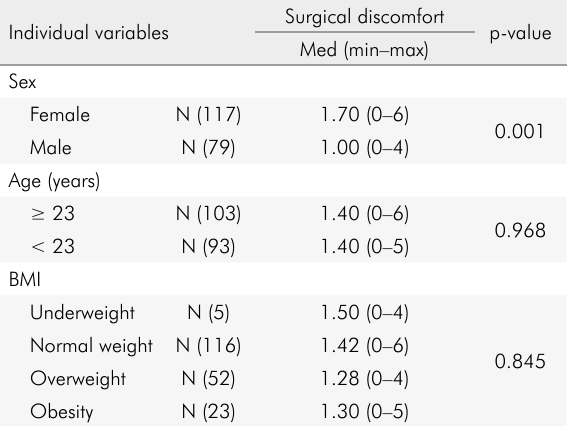
Table 2. Median (min and max) scores for surgical discomfort according to individual characteristics of the sample.